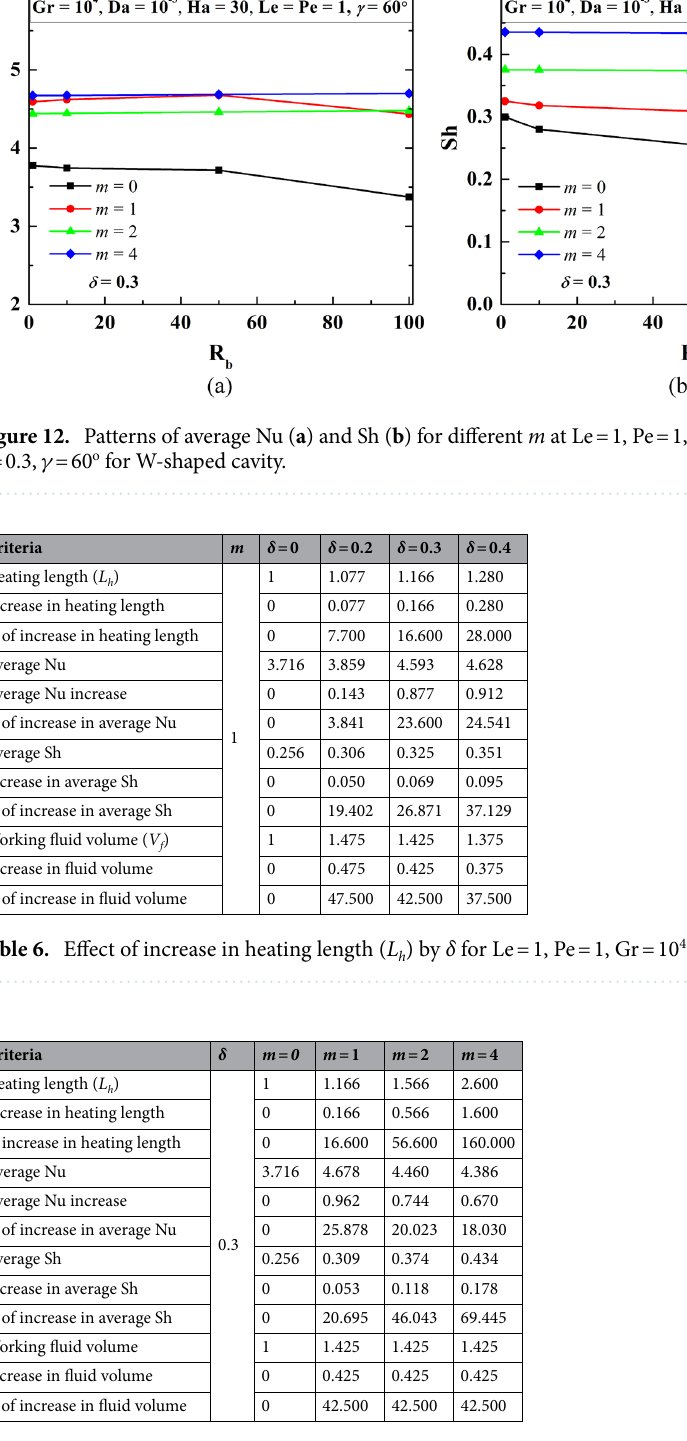
Table 7. Impact of increase in heating length ( L h ) by m for Le = 1, Pe = 1, Gr = 10 4 , Da = 10 –3 , Ha = 30, δ = 0.3, γ =